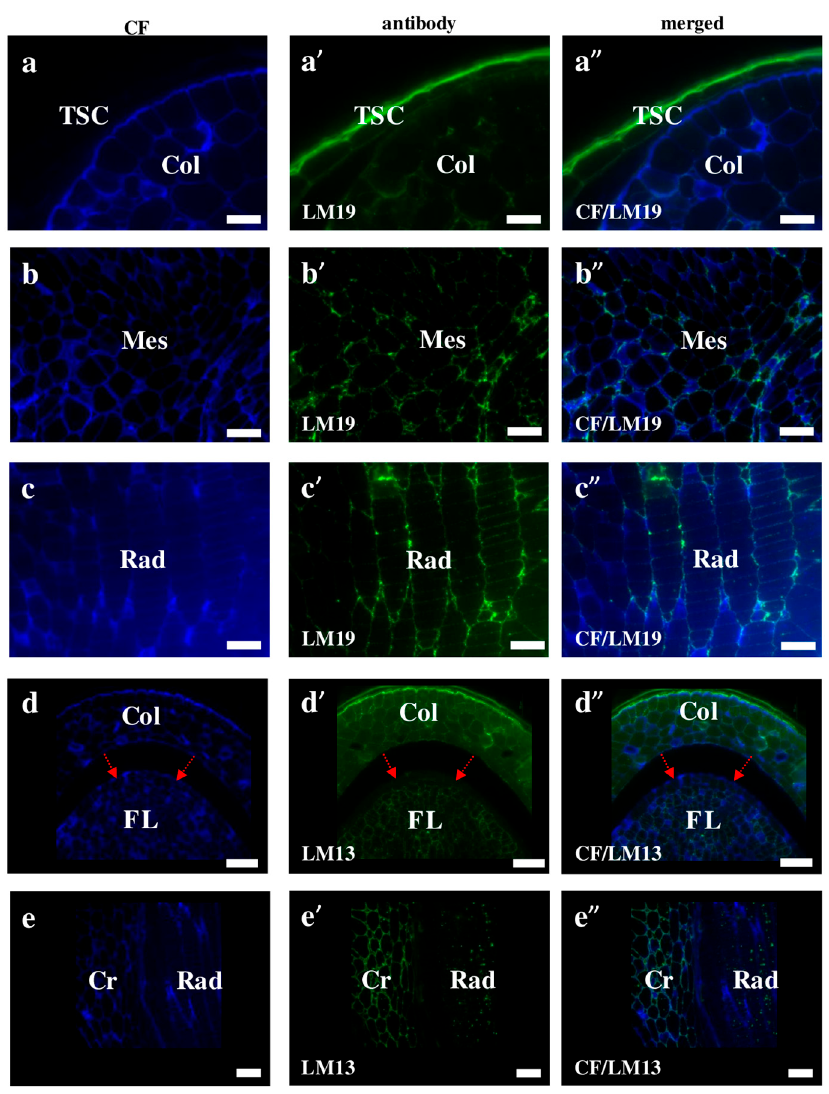
Figure 7. Immunolocalisation of pectins in Brachypodium embryos. ( a – a” , b – b” , c – c” ) Coleoptile with the seed coat, mesocotyl, and radicula are with LM19, respectively; Both ( d – d” ) coleoptile with first lead and ( e – e” ) coleorhiza with radicula with LM13. Arrows point to FL epidermal cells ( d – d” ).